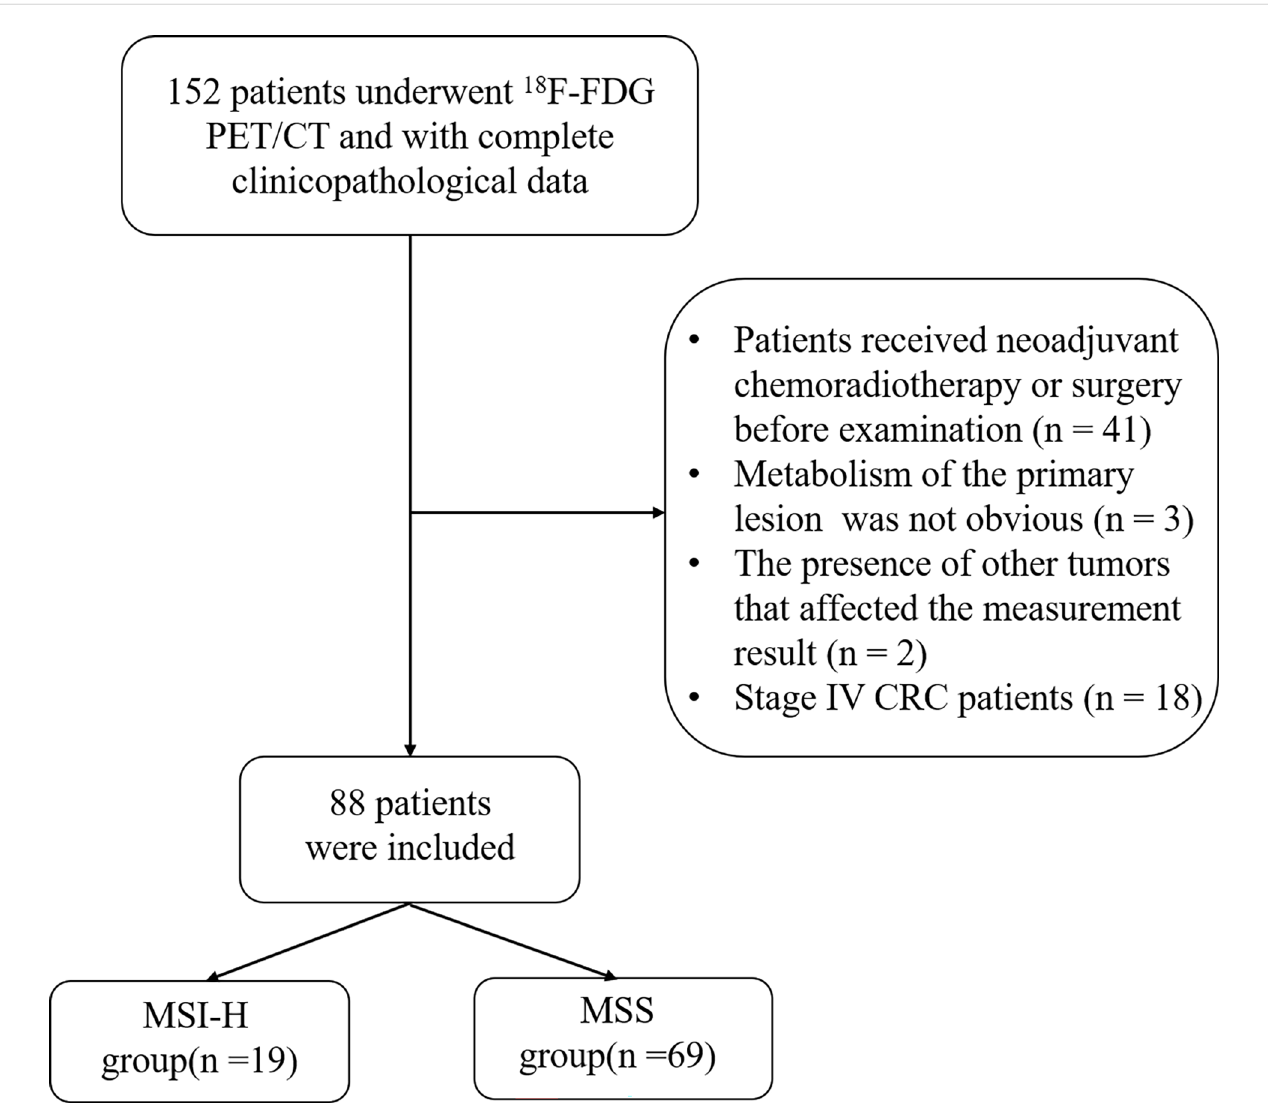
FIGURE 1 Flowchart of patient